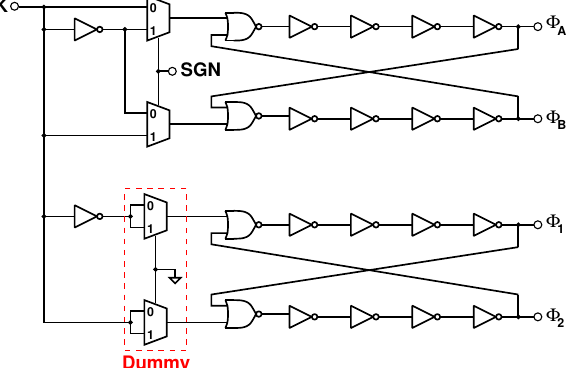
Figure 6. Circuit schematic of the non-overlapping phase generator (bottom) and the phase-swapping generator (top) for the switched-capacitor